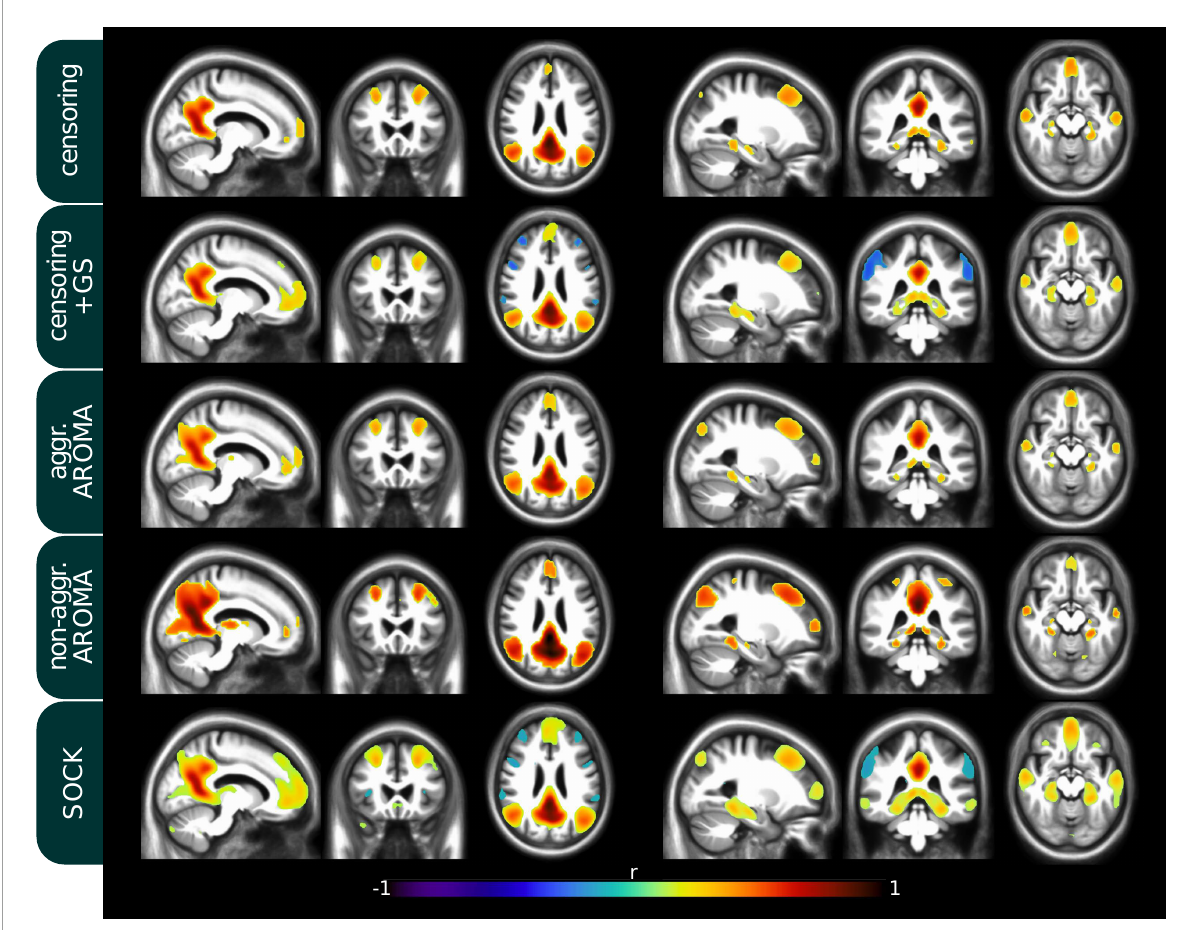
FIGURE4 Mean default mode network (DMN) connectivity map of 434 rrAD subjects in MNI space with the results of each of the regression approaches overlayed on the subject’s mean MPRAGE images. On average, the seed-based DMN can be calculated reliably with each of the 5 regression approaches and the differences are subtle. As expected, the regression of the global signal introduces task-positive anticorrelations for the censoring + GS approach but also for SOCK. Non-aggressive AROMA displays false positive connectivity in superior motor regions, while aggressive AROMA shows the best balance of separating basal ganglia subregions of the